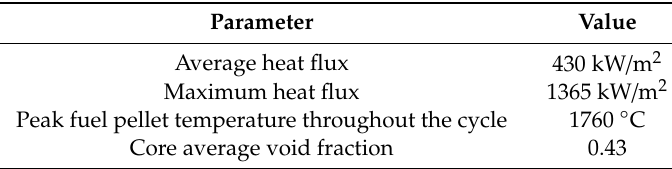
Table 4. Thermal hydraulic parameters at rated conditions